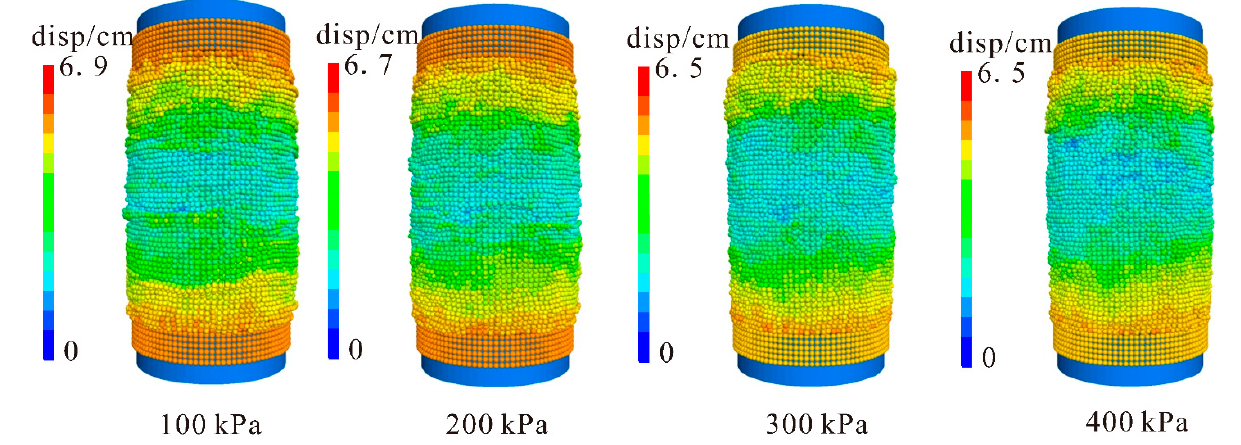
Figure 10. Final deformation of remolded soils.